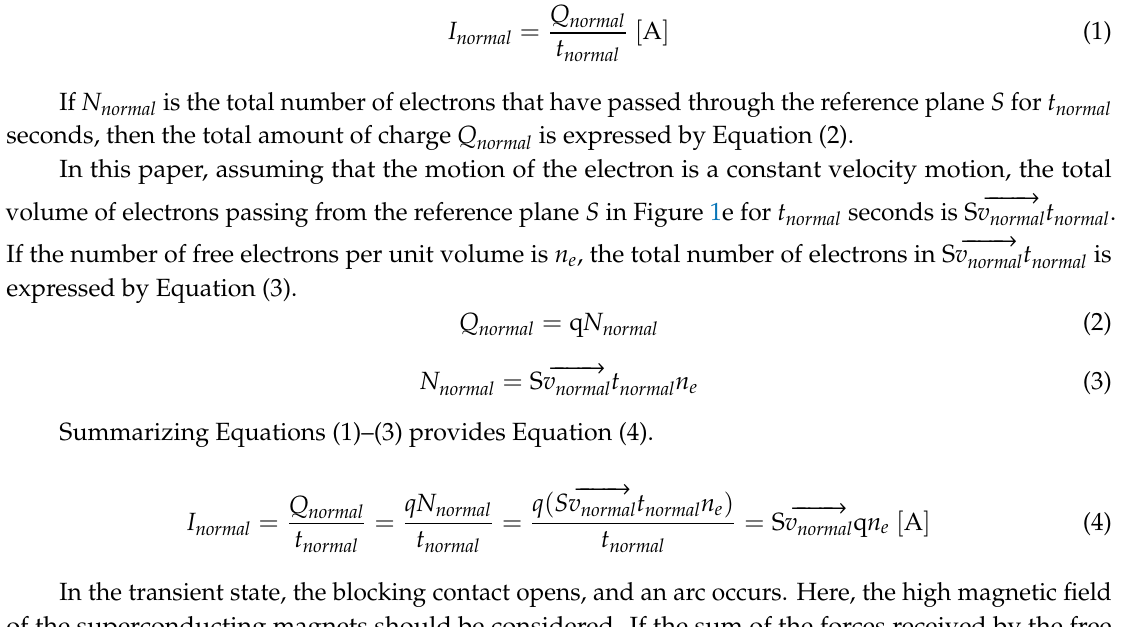
Figure 3. Forces received to the free electrons between mechanical contacts at the opening state. In the normal state, the blocking contacts (anode and cathode) are closed, and the normal current I normal flows. This can be expressed as Equation (1) as the flow of free charge per unit